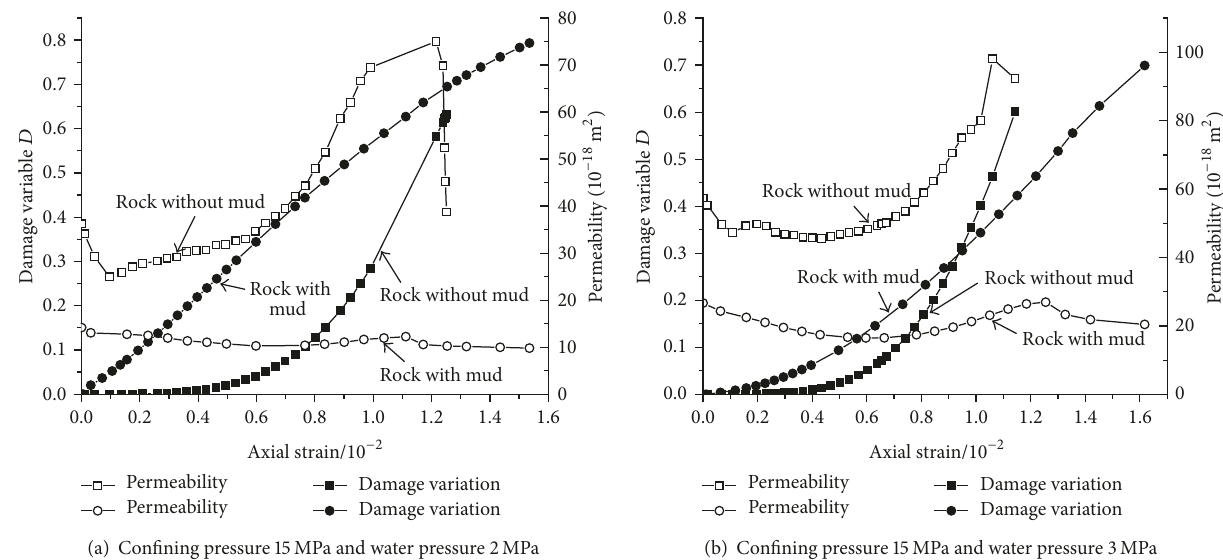
Figure 8: Damage and permeability variation induced by hydromechanical coupling